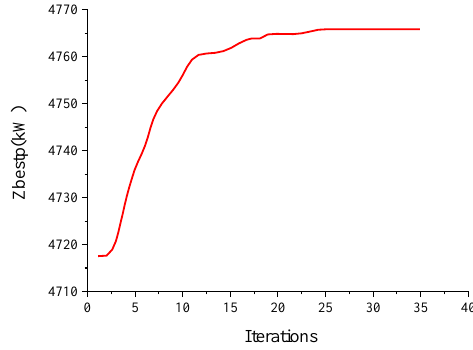
Figure 12. Evolution of particle swarm at rated wind speed.